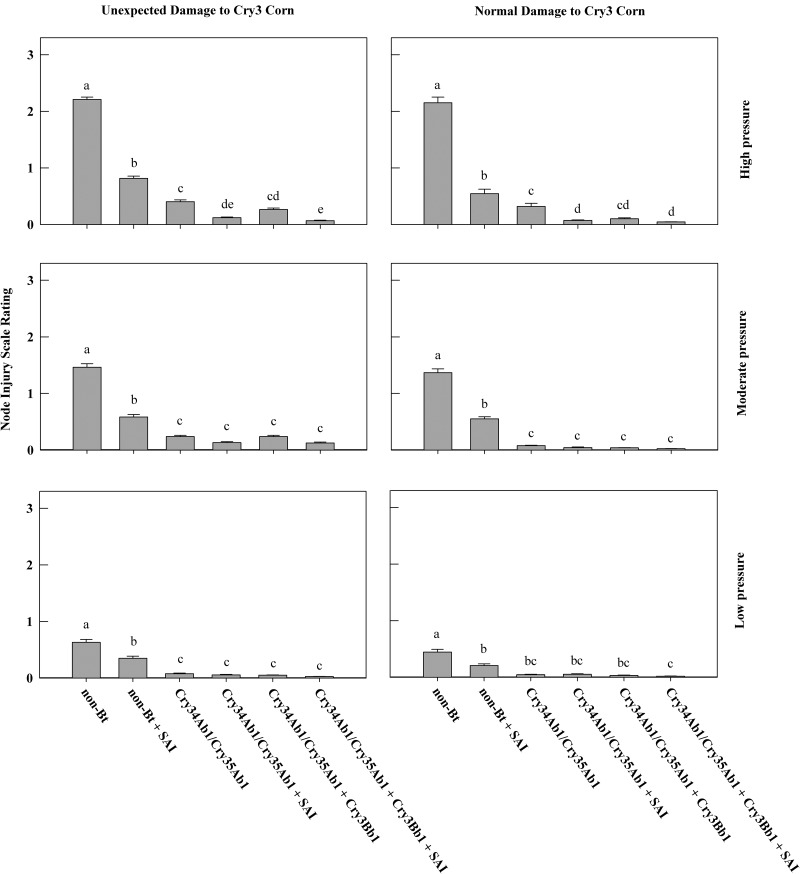
Mean node injury scale (NIS) rating ± standard error of corn hybrids with or without soil-applied insecticide (SAI), presented by level of corn rootworm injury to Cry3-expressing corn (normal or unexpected) and under high (>2 NIS), moderate (1–2 NIS), or low (<1 NIS) root feeding pressure. NIS ratings with the same letter do not differ significantly (LSD, α = 0.05).